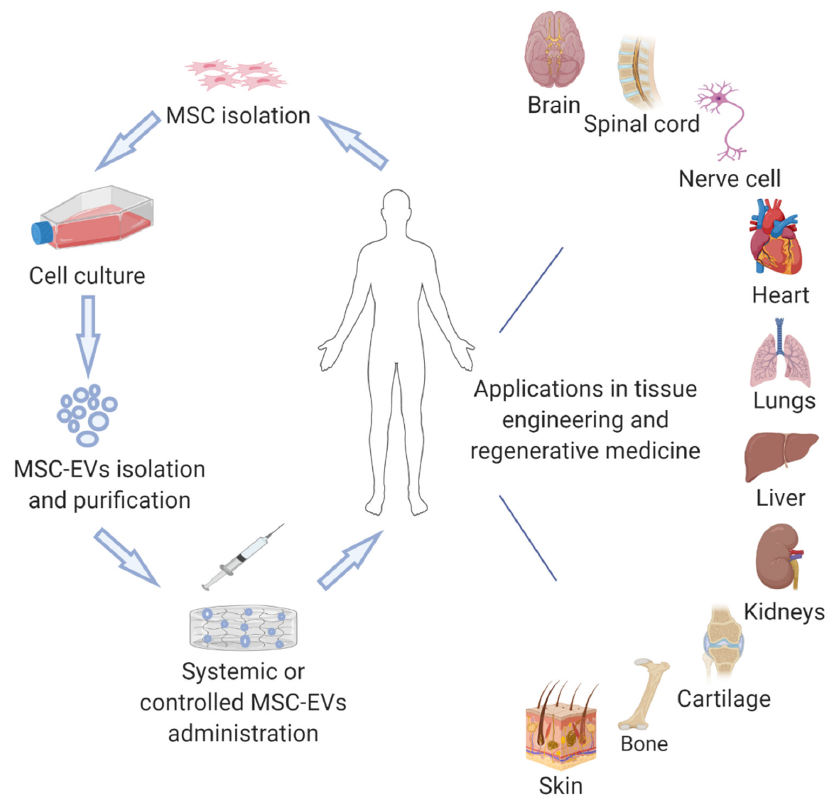
Figure 1. Examples of potential applications of MSC-EVs in tissue engineering and regenerative medicine.